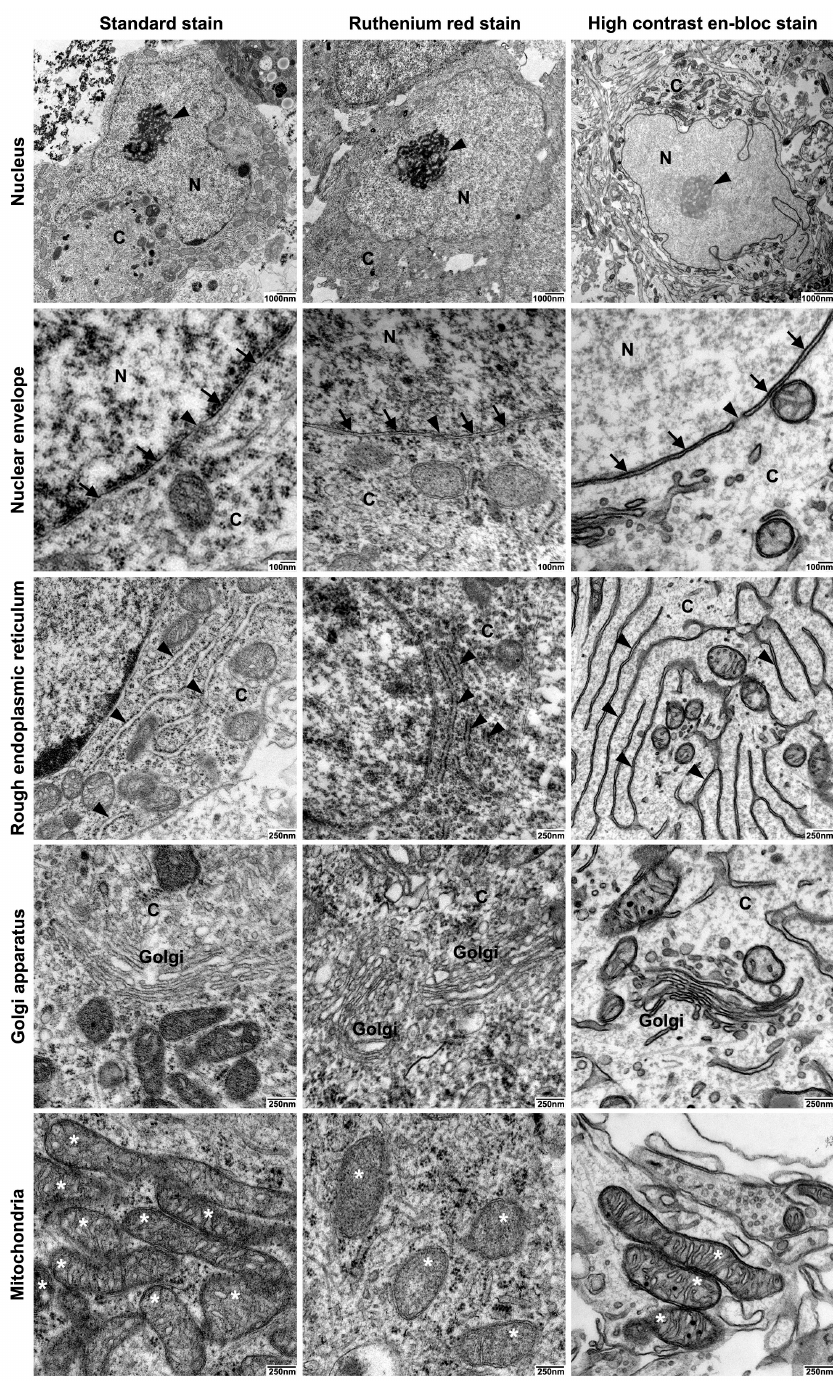
Figure 3. Comparison of the three fixation and staining protocols: Neuronal soma. Three TEM preparation protocols were compared with respect to ultrastructural preservation and optimal visualization of biological membranes of neuronal somata and cellular organelles: Transmission electron micrographs from cultured iNSC-derived neurospheres prepared using standard TEM staining protocol (standard stain, left column), Ruthenium red staining protocol (Ruthenium red stain, middle column), or high contrast electron microscopic staining protocol (high contrast en-bloc stain, right column). Panel 1: Neuronal soma. Soma showing cell nuclei (N) and nucleoli (arrowhead). Note the strong contrast of cellular membranes after sample processing with high contrast en-bloc staining protocol. C: Cytoplasm. Scale bars: 1000 nm. Panel 2: Nuclear envelope and nuclear pores. Preservation of the nuclear envelope (arrows) was improved by sample processing with high contrast en-bloc